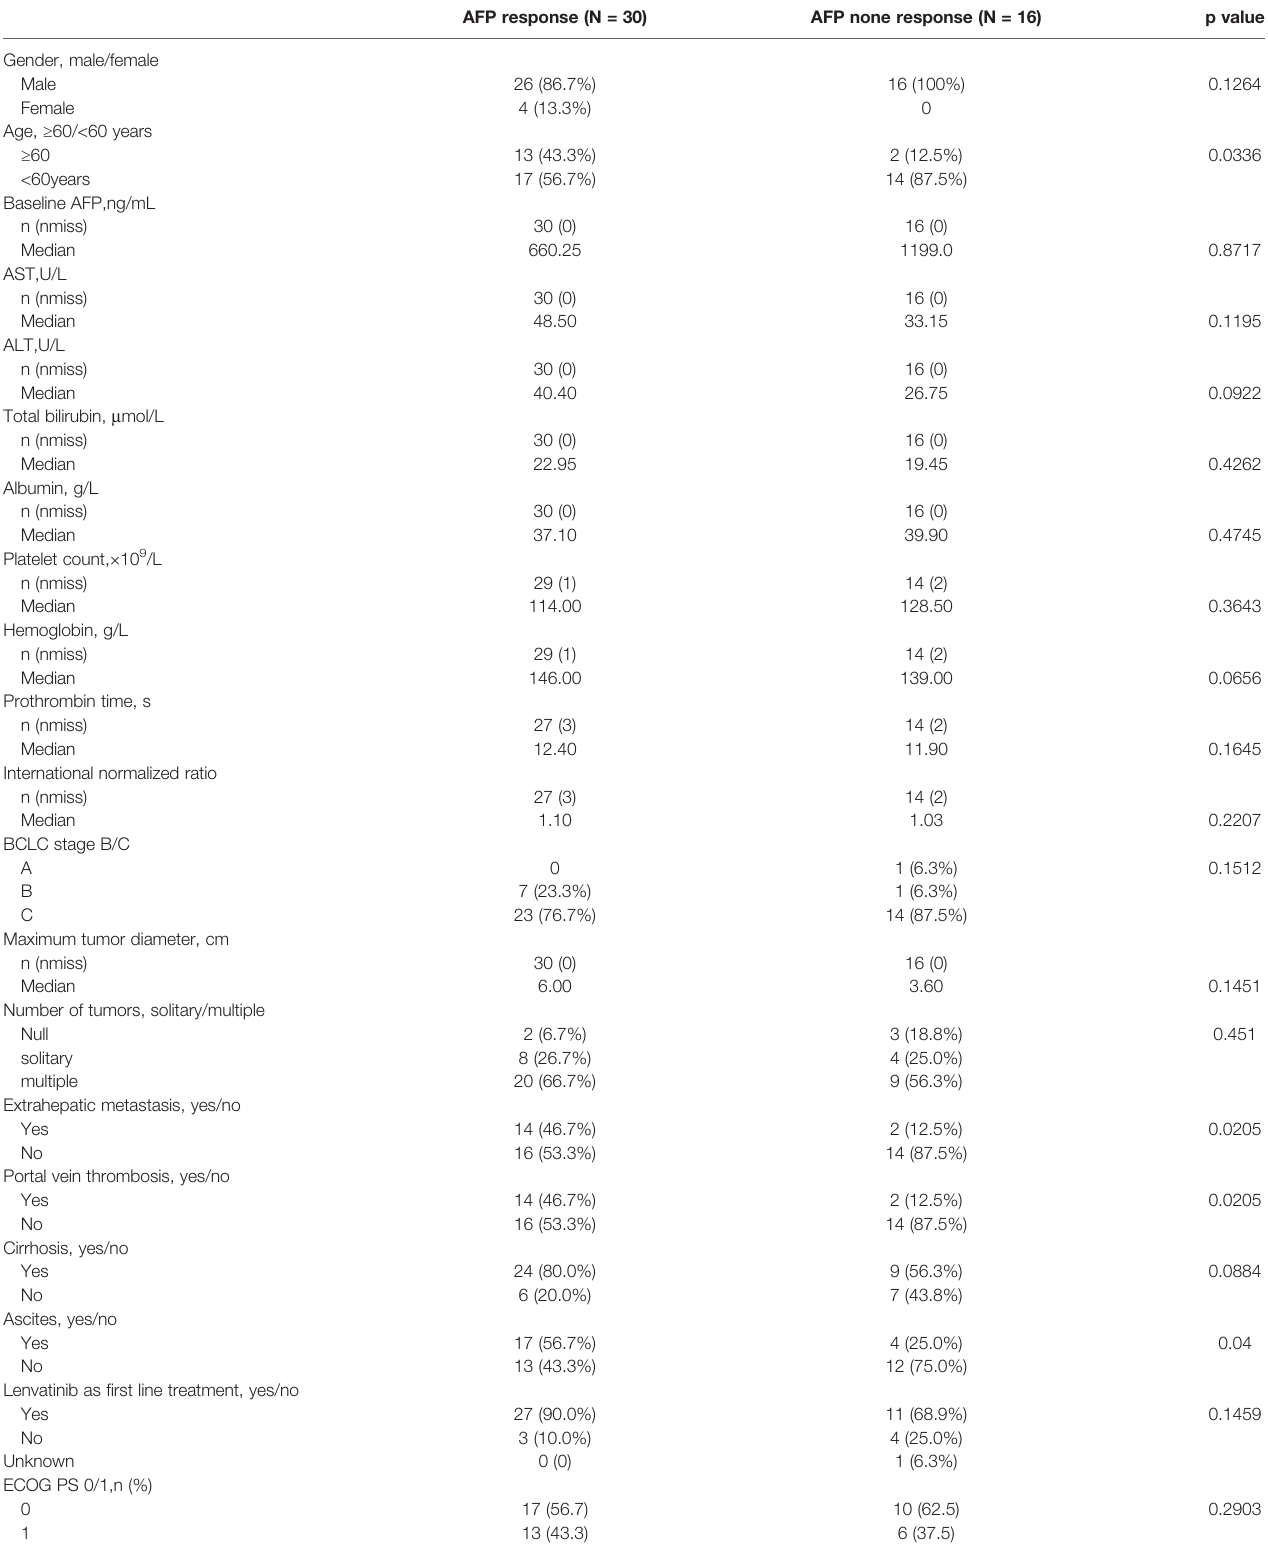
TABLE 1 | Baseline characteristics by AFP